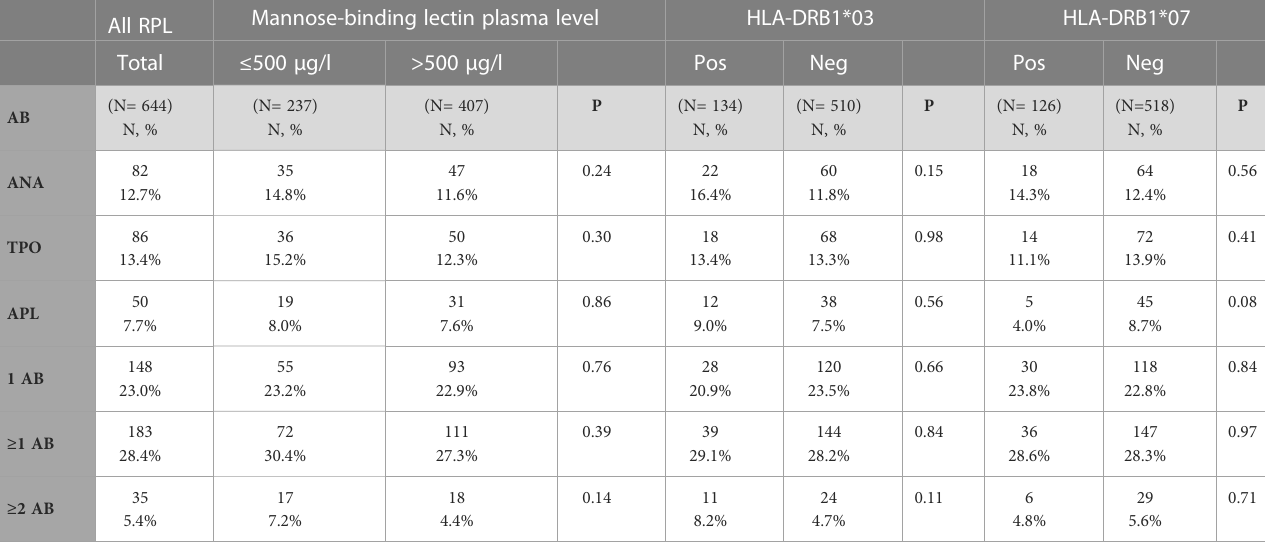
TABLE 2 The frequencies of antibody positivity in all RPL patients and when grouping the patients according to plasma-MBL level, HLA-DRB1*03, or HLA- DRB1*07 phenotype, respectively. All RPL